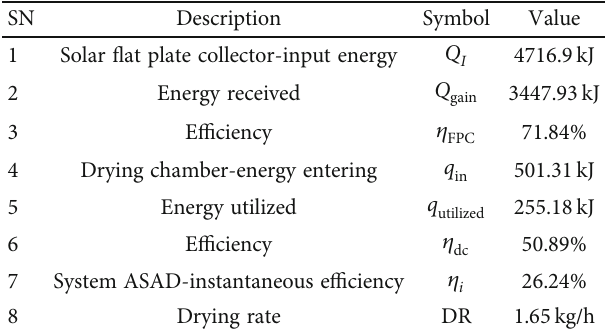
Table 4: Important results of forced convection FPC solar